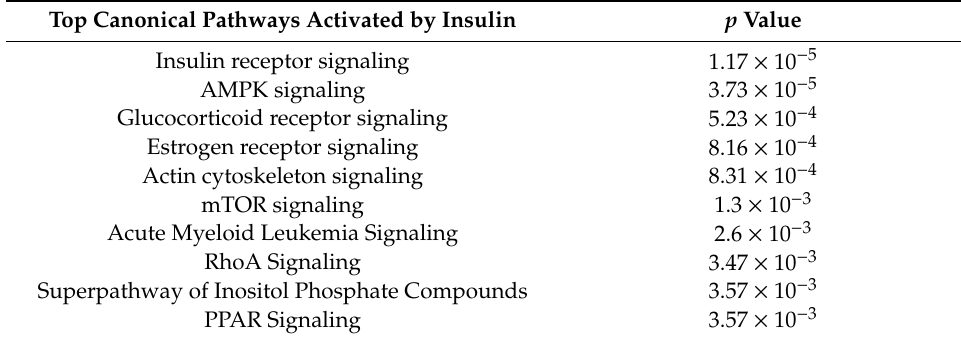
Table 2. Pathways significantly a ff ected by insulin in 3T3-L1